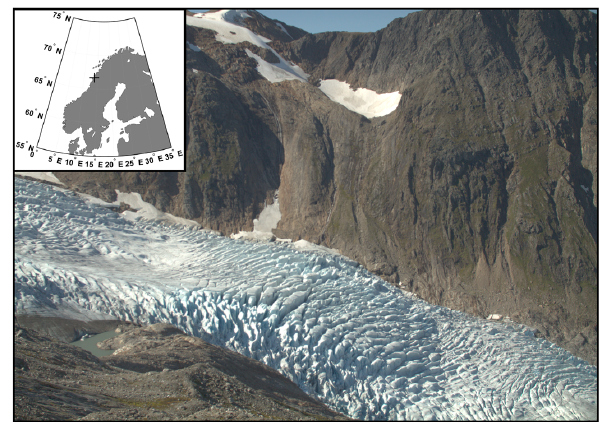
Figure 1. A sample image taken by the time-lapse camera located at Engabreen, northern Norway (inset). Note the distinct crevasse features in the main